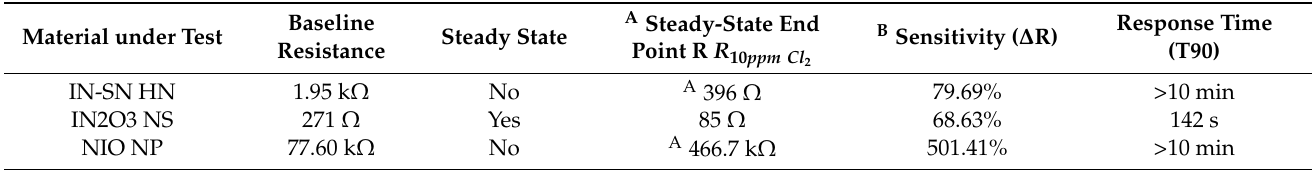
Table 1. Summary of Cl 2 gas sensitive material’s sensitivity and responsiveness to 10 ppm Cl 2 (in N 2 bal.) at 260 ◦